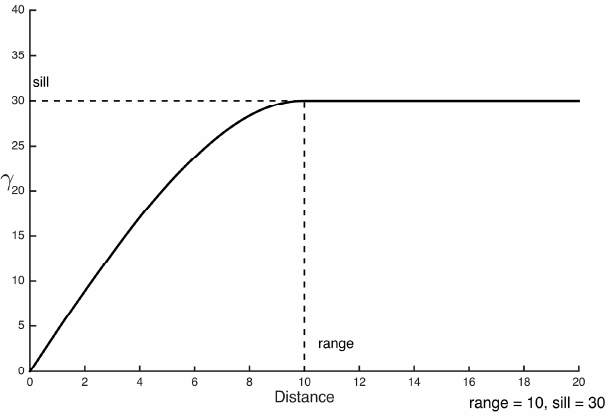
Figure 2. An ideal curve of a semivariogram with a range of 10 and a sill of 30.